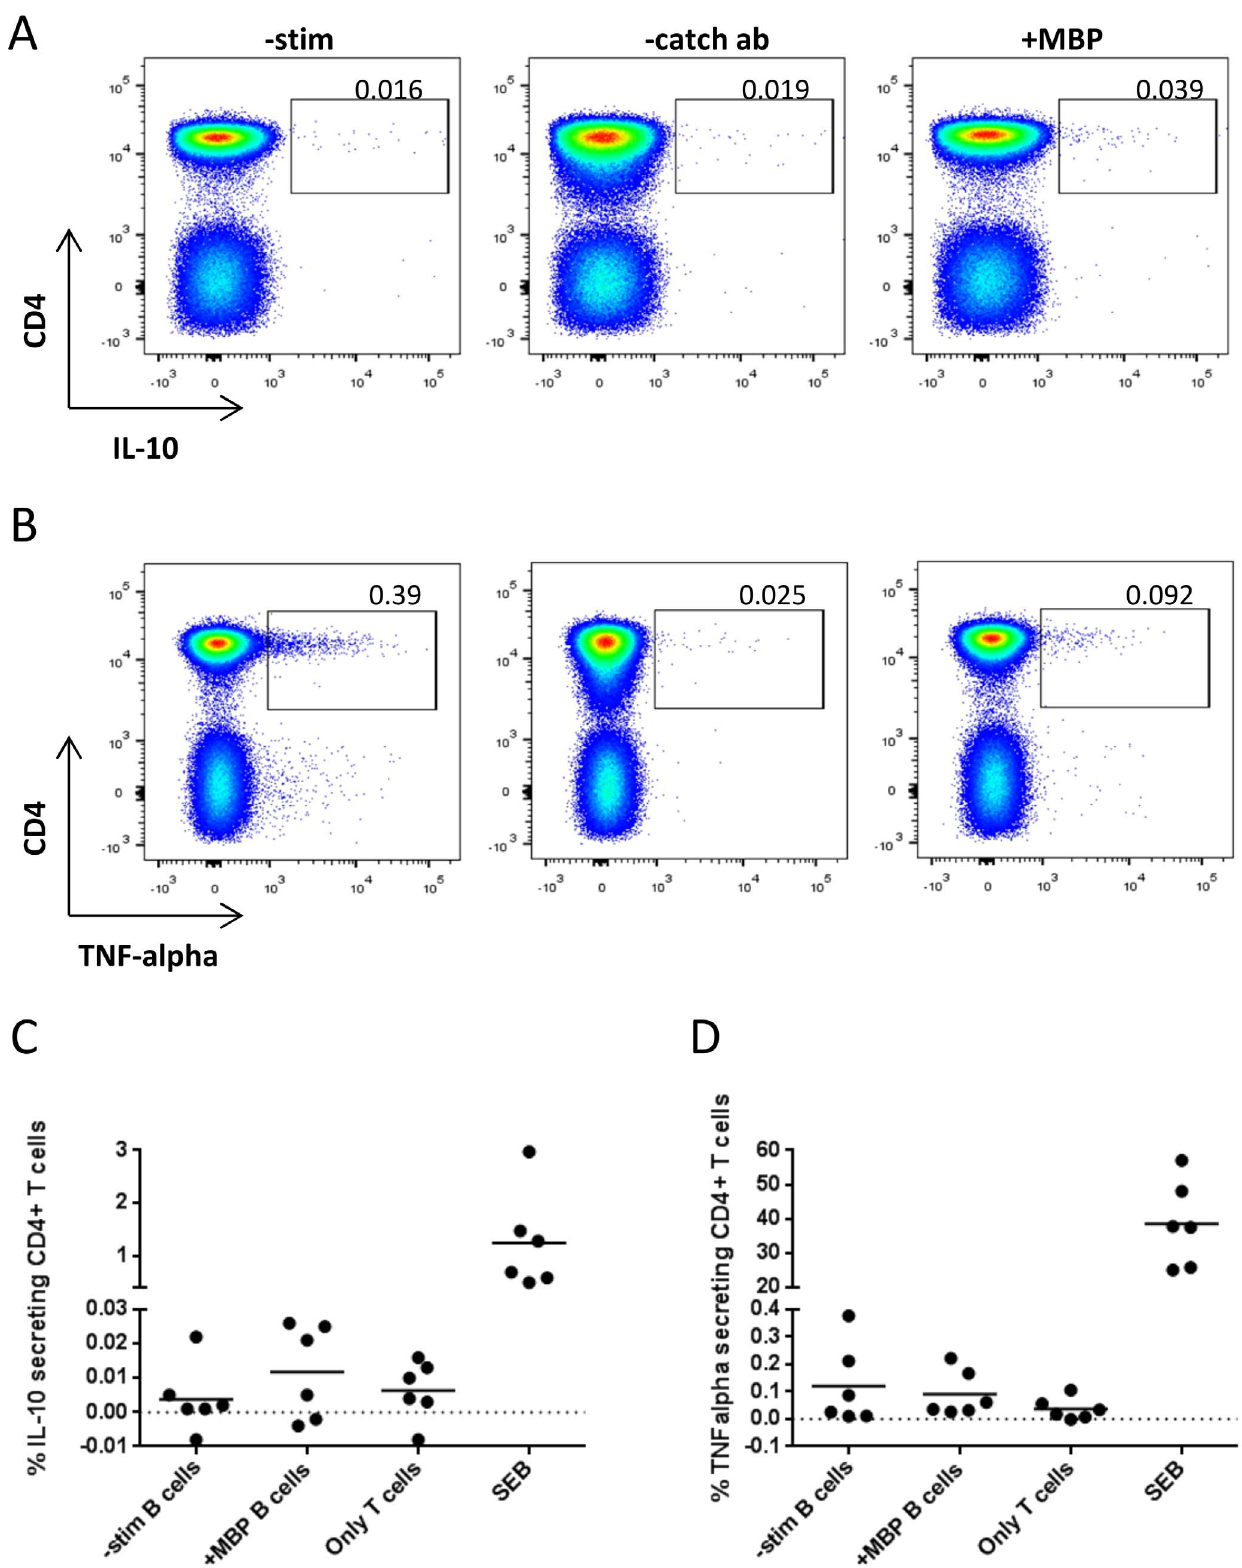
Figure 6. IL-10 and TNF-alpha secretion by MBP specific CD4 + T cells in co-cultures of T cells and B cells. 500,000 CD3 + T cells were cultured with 100,000 CD19 + B cells 6 30 m g/ml MBP for 18 h and the resulting IL-10 and TNF-alpha production in CD4 + T cells were measured. Shown is representative dot plots of (A) IL-10 and (B) TNF-alpha production in CD4 + T cells and individual values of the proportion of CD4 + T cells producing (C) IL-10 or (D) TNF-alpha (N=6). Cultures stimulated by staphylococcal enterotoxin B (SEB) were used as positive controls and cultures